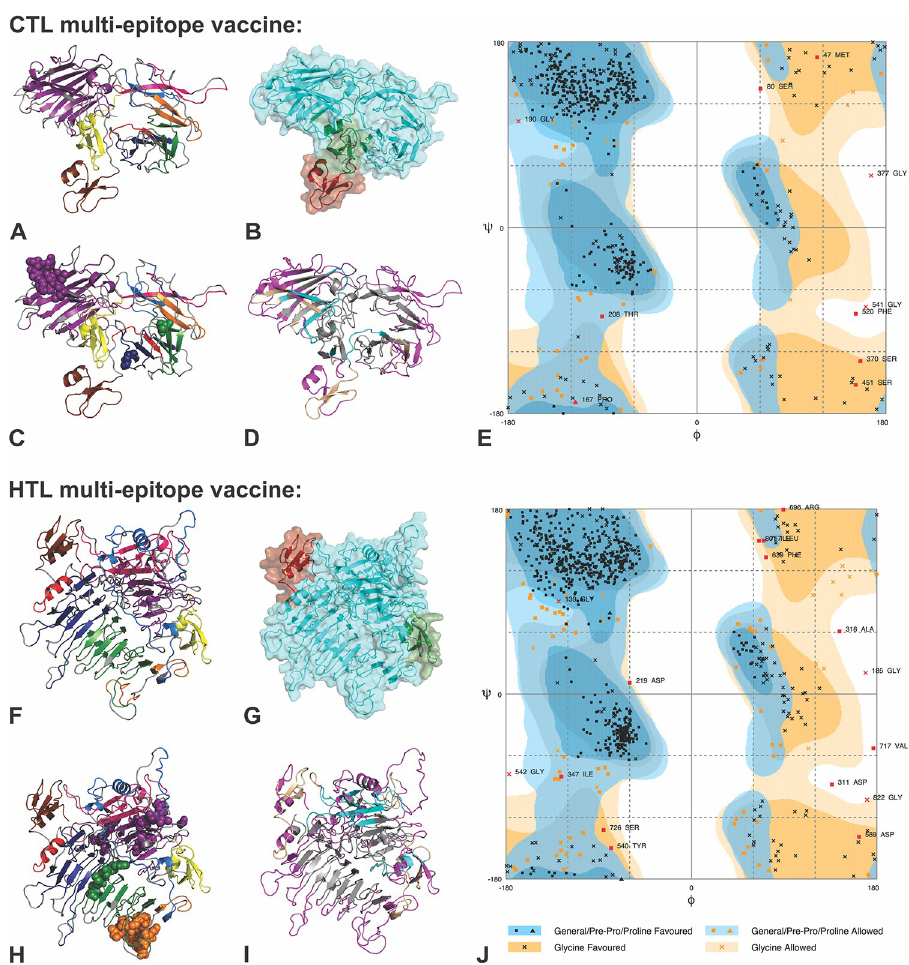
Fig 6. Tertiary structure modelling of CTL and HTL Multi-Epitope Vaccines. (A) & (F) : Tertiary structural models of CTL and HTL MEVs showing epitopes in different colors corresponding to the epitopes color as shown in Fig 5. (B) & (G) : Show the different domains of CTL and HTL MEVs. (C) & (H) : The overlapping linear B cell epitope region present in CTL and HTL MEVs, shown by spheres. (D) & (I): From the CTL and HTL MEVs, the INF- γ inducing epitopes are shown in cyan, discontinuous B Cell epitopes are shown in magenta and the region common amongst INF- γ and discontinuous B Cell epitopes are shown in wheat color. (E) & (J) : RAMPAGE analysis of the refined CTL and HTL MEV